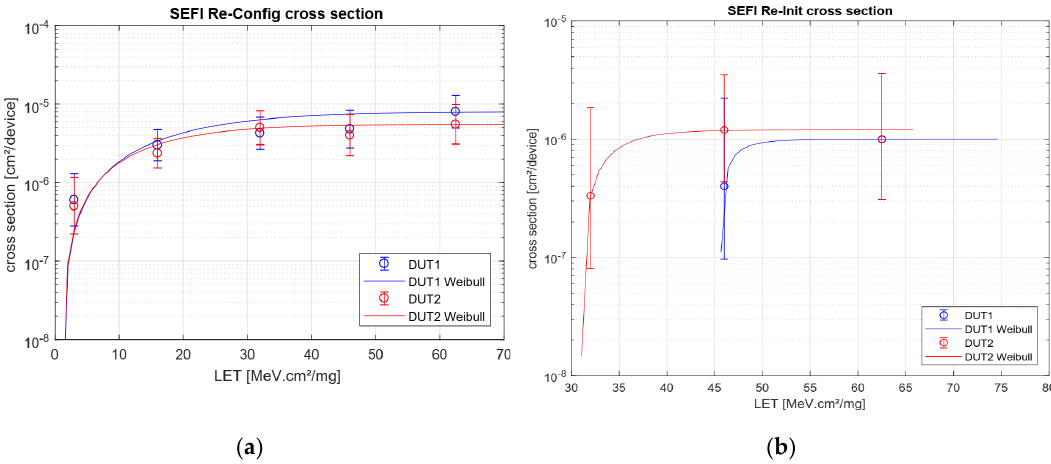
Figure 9. Single event upsets (SEU) cross section ( a ) SEU and ( b ) multiple bit upsets (MBU) cross section for both DUTs with a corresponding Weibull fitting curve (W = 29.43, S = 1.63).